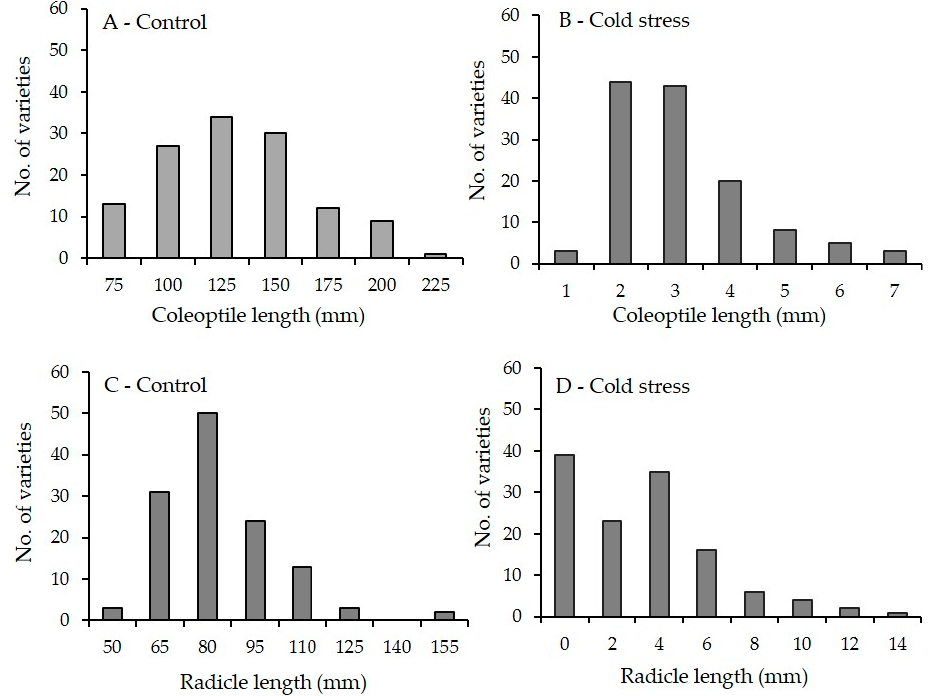
Figure 2. Frequency distribution of coleoptile length ( A , B ) and radicle length ( C , D ) of rice varieties under the control (25 °C) and cold stress (13 °C) conditions.